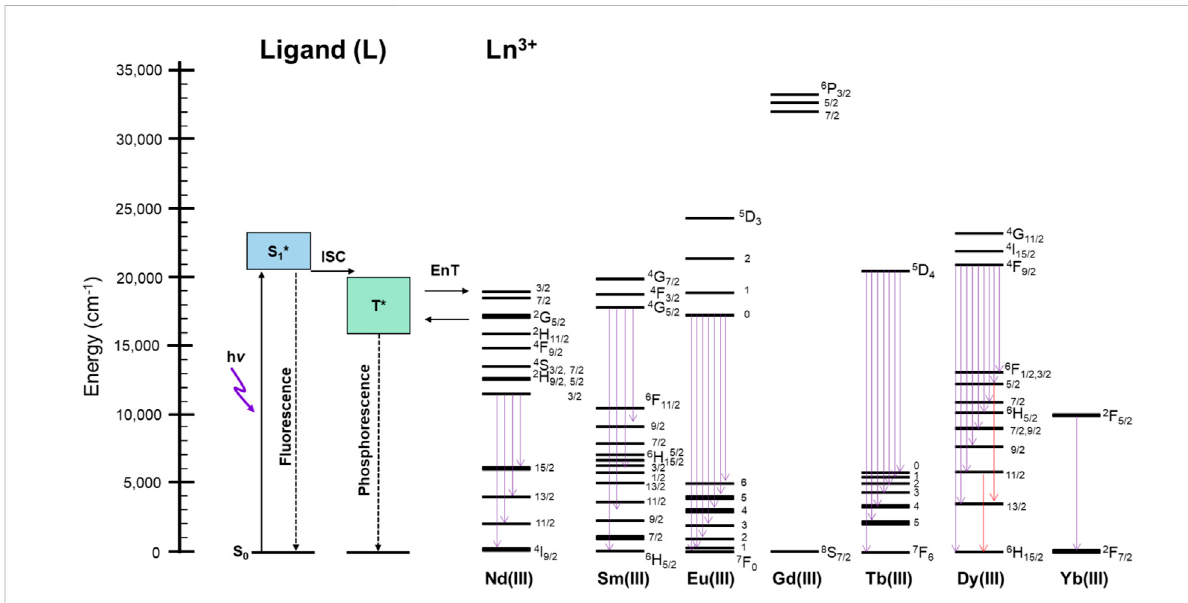
FIGURE 5 Schematicrepresentationoftheenergyrelaxationprocessatrtand77 KofLn L inthesolidstate.ISC:intersystemcrossing;EnT:energytransfer; Flu.: fl uorescence; Phos.: